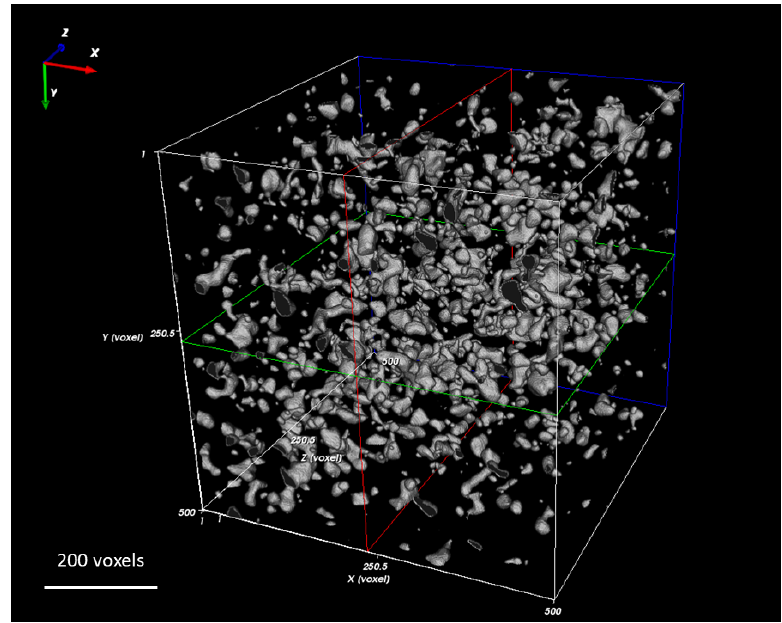
Figure 3. Pore space of mudstone (sample 27), poROSE software.